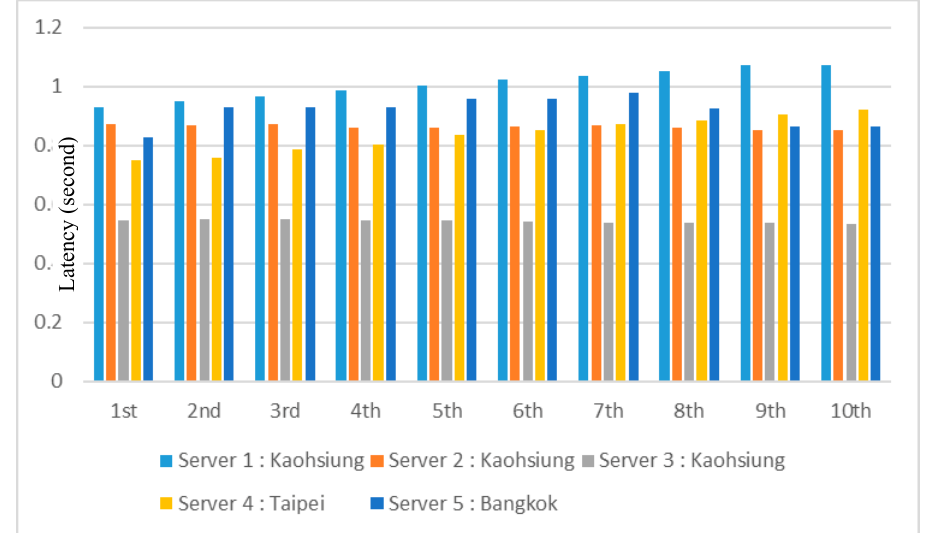
Figure 20. Latency average of five di ff erent servers using ADSL communication; latency time in seconds on Y axis, test number on X